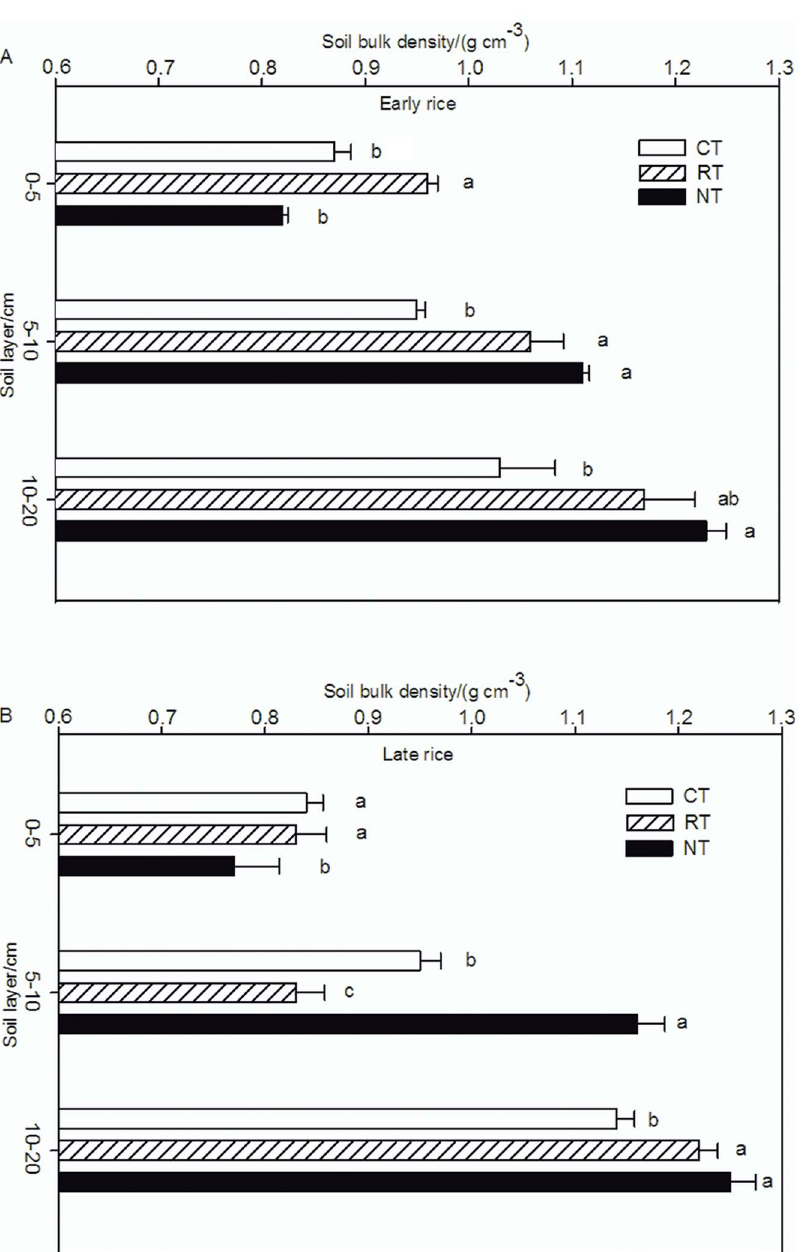
Figure 1. Soil bulk density of different tillage treatments in 2008 (A for the early rice season and B for the late rice season). Data are means of three replications; means followed by different letters are significantly different at P , 0.05. Sampling was done during the harvest of the early and late rice in 2008.